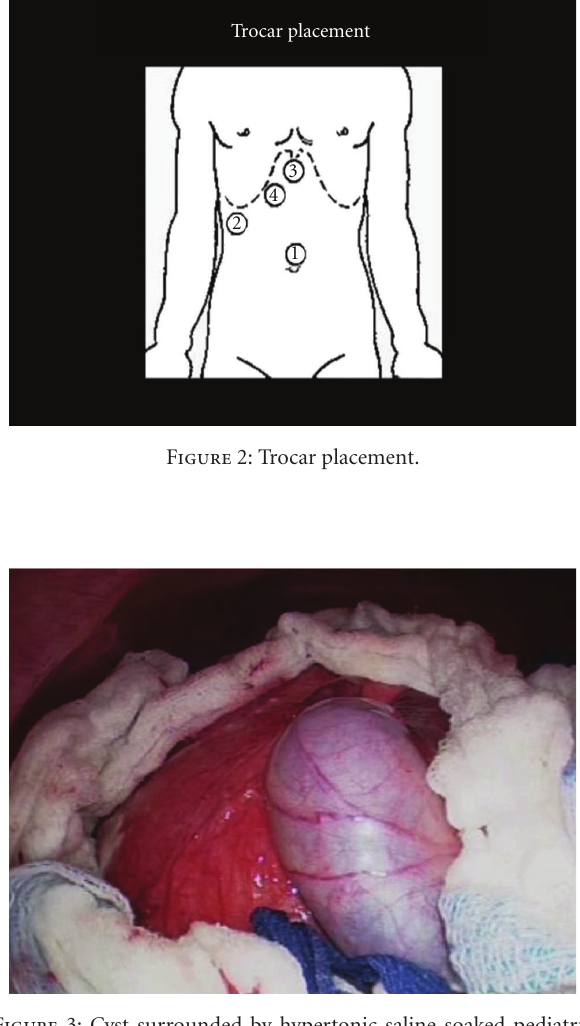
Figure 3: Cyst surrounded by hypertonic saline-soaked pediatric laparotomy pads.